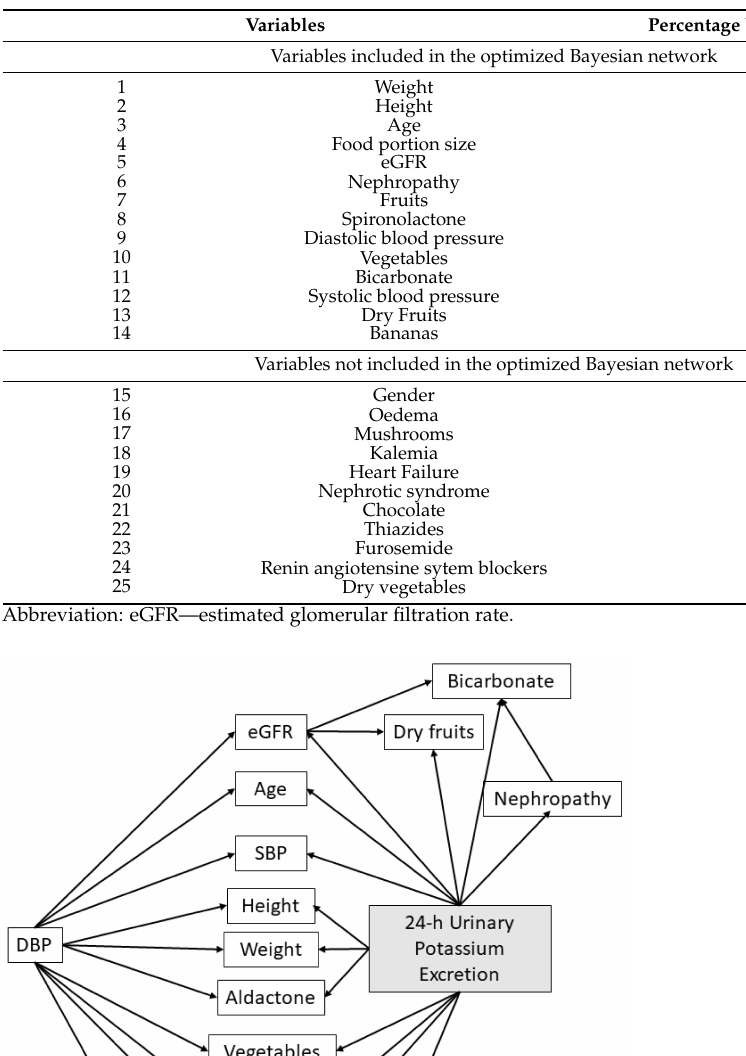
Table 2. Percentage variance between explanatory variable and potassium consumption for all 25 baseline variables.